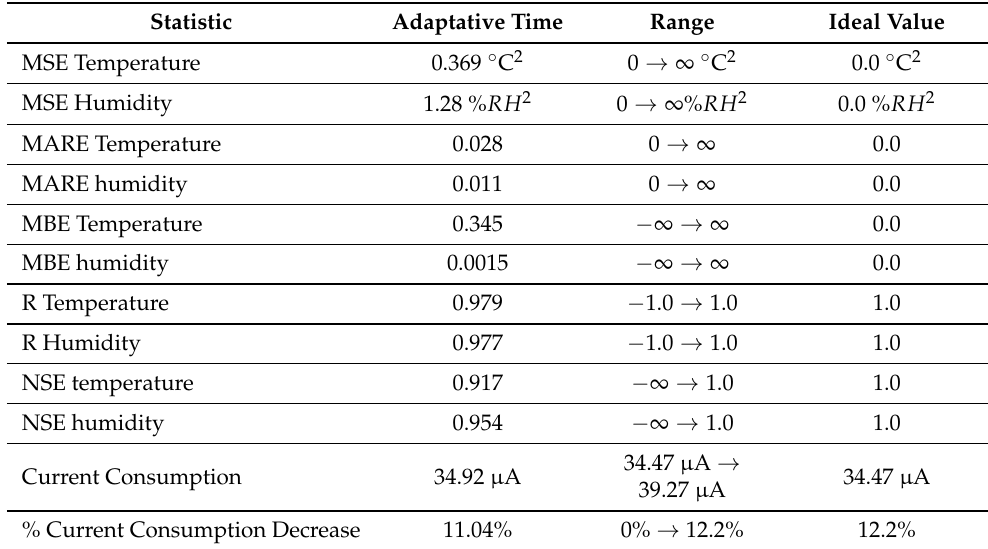
Table 2. Statistics used for evaluation energy system management.